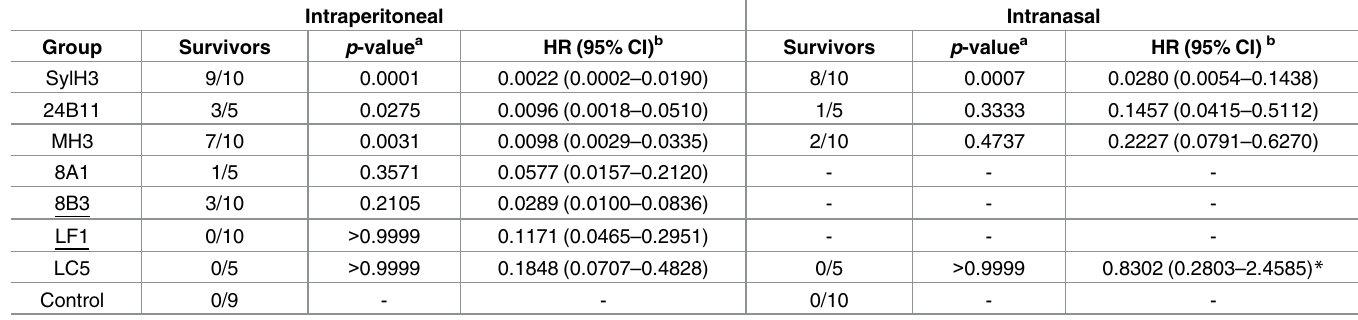
Table 3. mAb passive protection studies in mouse models of systemic and mucosal ricin challenge.